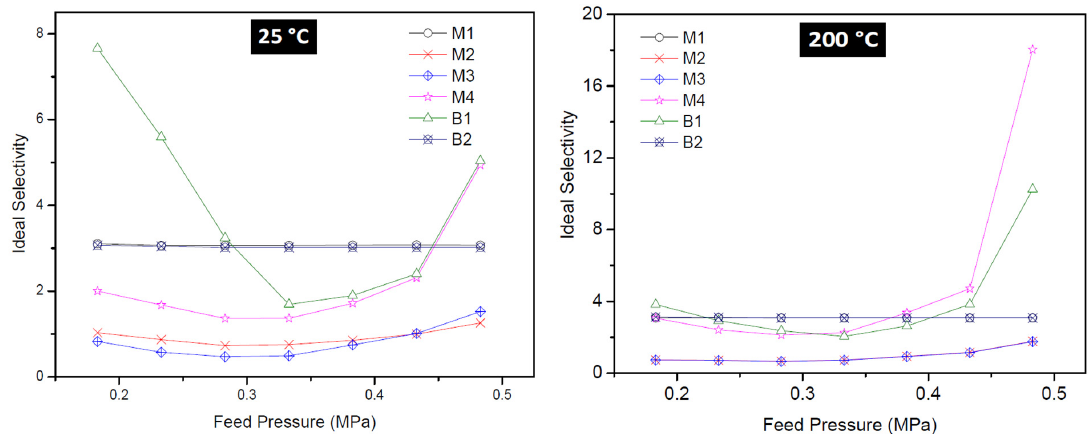
Figure 11. Ideal selectivity of H 2 /CO 2 as a function of feed pressure of all membranes at 25 °C ( left ) and 200 °C ( right ).